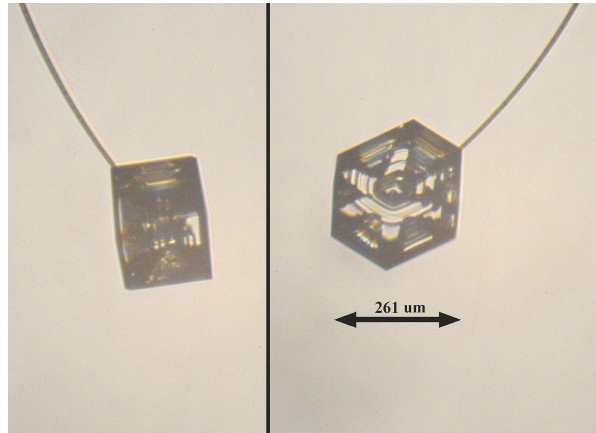
Figure 4. Side and front view of skeletal crystal grown on C f